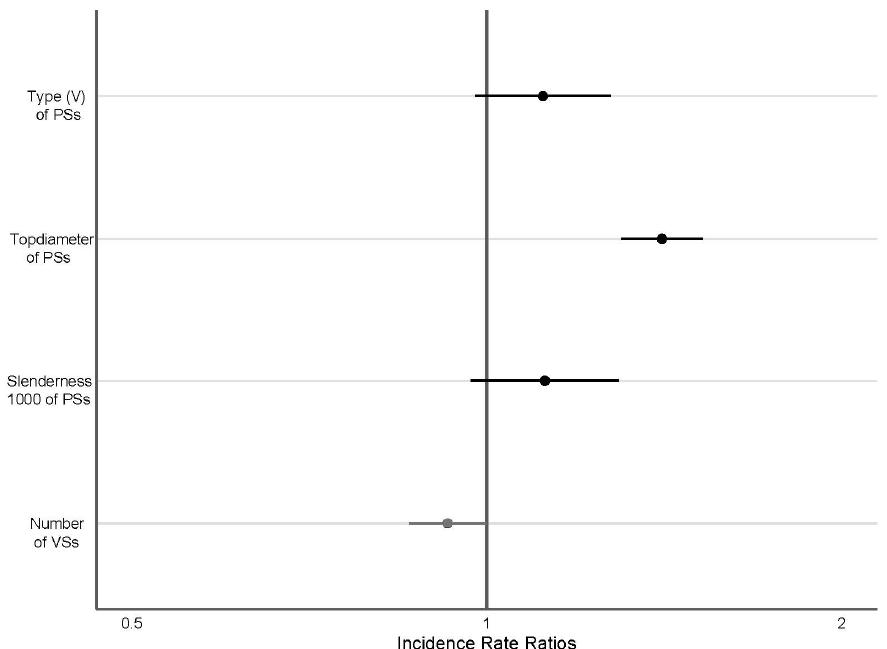
Table 2. Zero-in fl ated model of the total yield of the parent shoots (PSs).